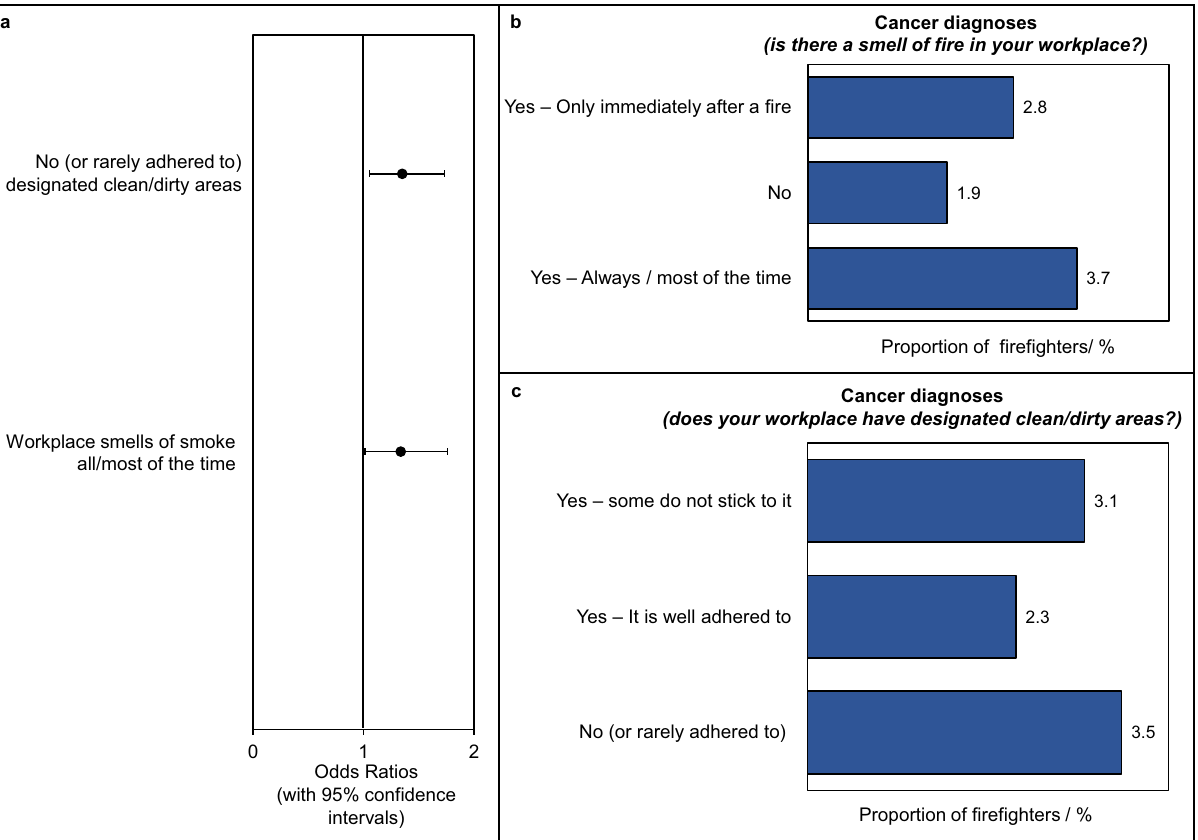
Figure 6. Workplace contamination and cancer diagnosis in the UK Fire and Rescue Service. ( a ) Cancer odds ratios for measures of workplace contamination. ( b ), ( c ) The proportion of firefighters in each